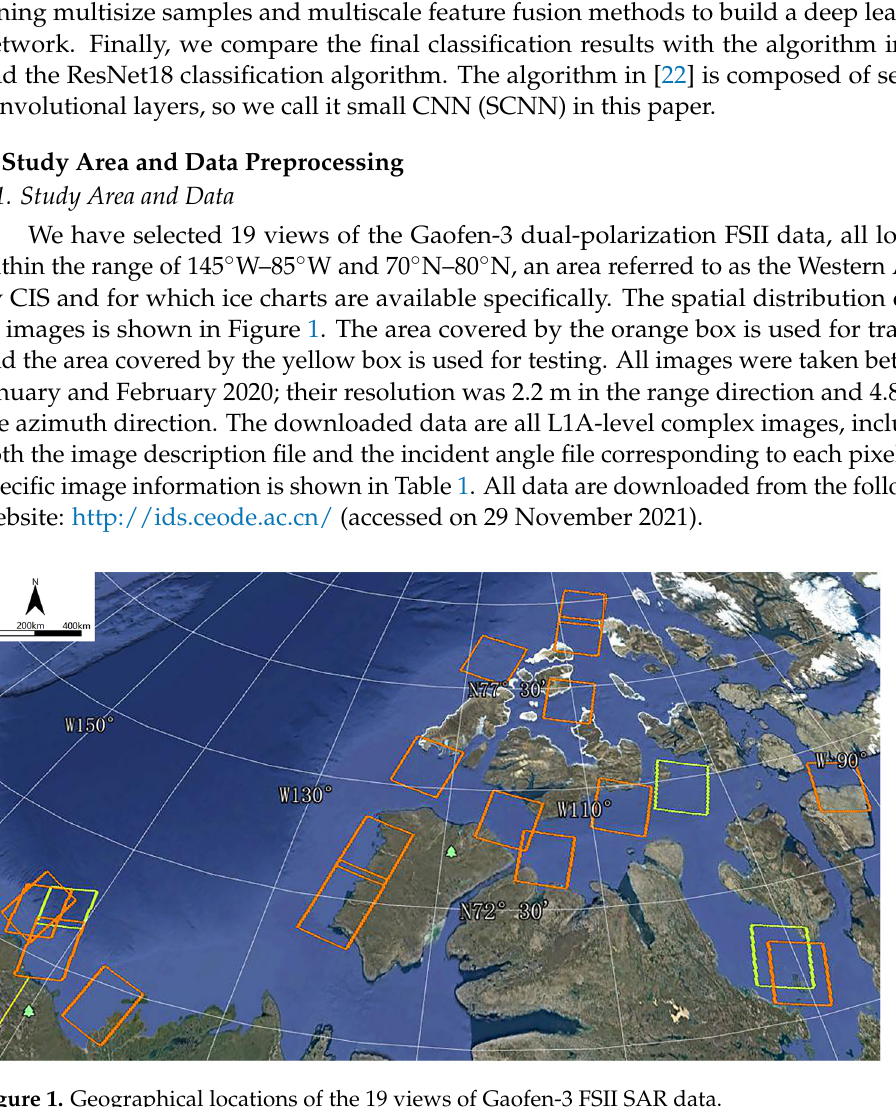
Figure 1. Geographical locations of the 19 views of Gaofen-3 FSII SAR data.